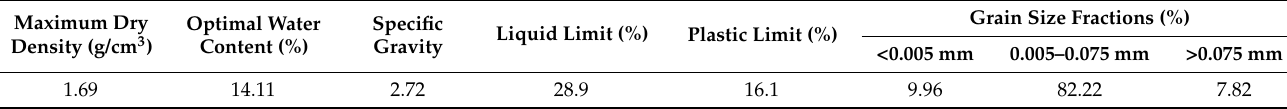
Figure 1. Loess distribution and sampling site in Shaanxi, China. Table 1. Physical and mechanical parameters of the studied loess